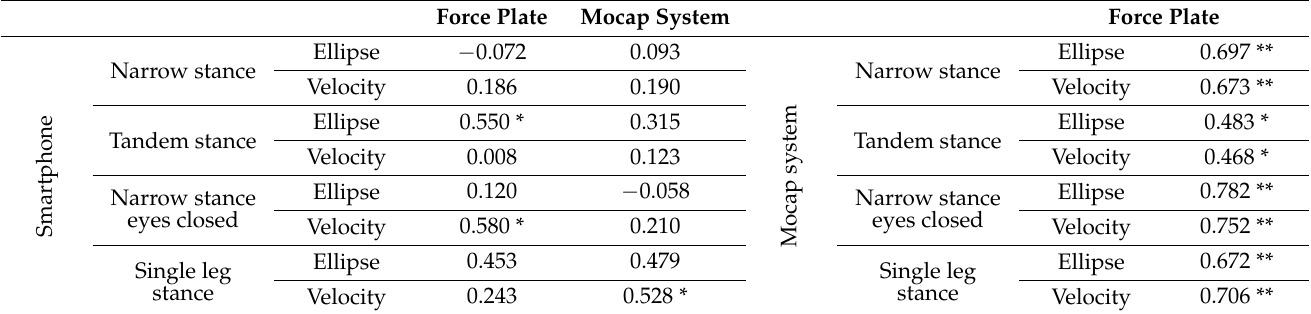
Table 8. Between-system correlations for the stance tasks at T1. Cor. = correlation after Pearson. NS = narrow stance. TS = tandem stance. NSEc = narrow stance with eyes closed. SS = single leg stance. The number of participants included in each analysis varied between 14 and 24.